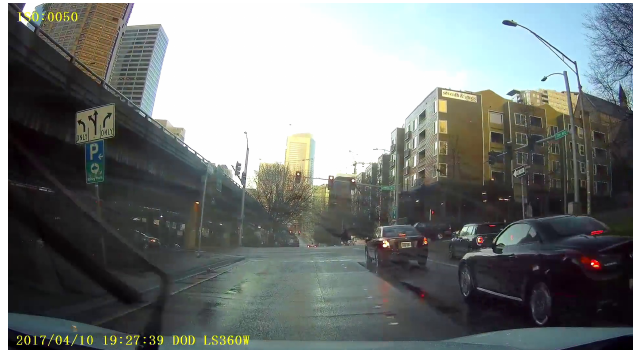
Figure 1. Multiple weather conditions (sunny and wet) existing in a single